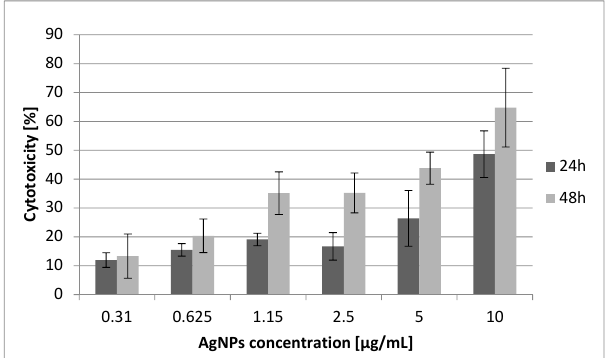
Figure 1. Cytotoxic effects of silver nanoparticles (10 nm diameter, concentrations 0.31 μ g/mL–10 μ g/mL) on SCC-25 cancer cells. The percentage of cell death measured by MTT cytotoxicity assay. MTT values represent mean ± SD of three independent cytotoxicity experiments performed in quadruplicate ( n = 12). The lower concentration of AgNPs (e.g., 0.625 μ g/mL) after 48 h produced the same killing effect on SCC-25 cells (20%) as 3 μ g/mL AgNP concentration after 24 h. Mean cytotoxicity between different AgNPs concentrations alone were highly significant above the concentration of 2.5 μ g/mL ( p < 0.01, ANOVA Friedman ANOVA test, Wilcoxon test).